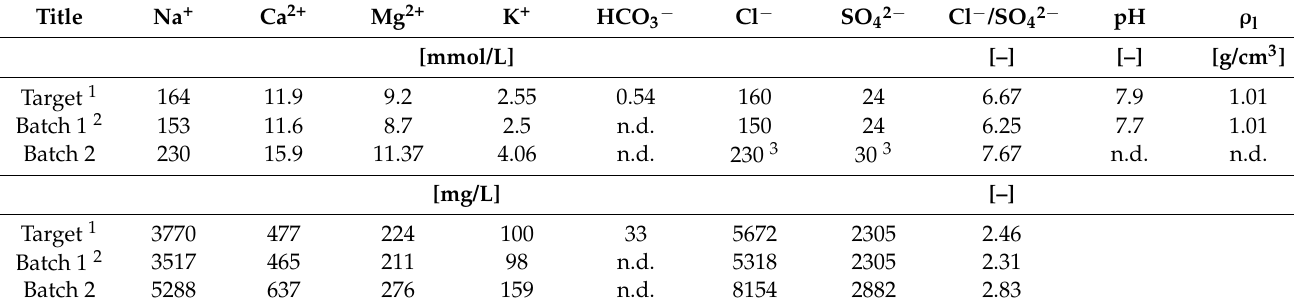
Table 2. Pearson water composition at sandy facies of Opalinus Clay [8], pH and liquid density ( ρ l